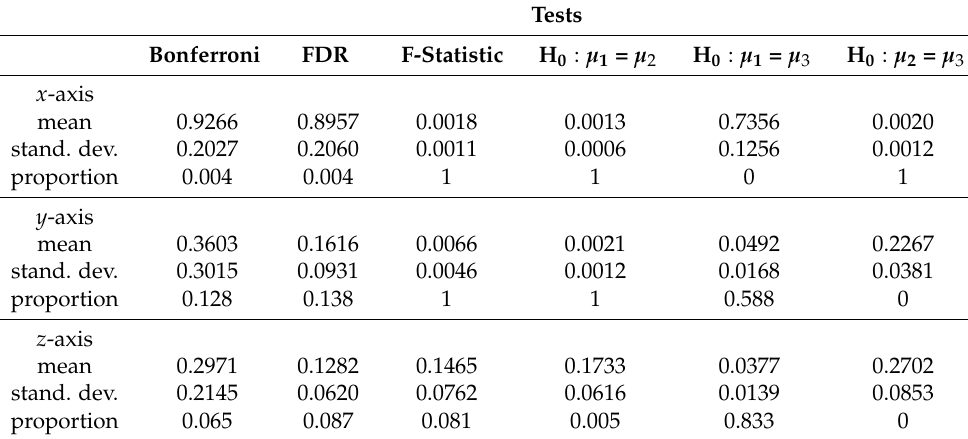
Table 1. Mean, standard deviation and proportion of values smaller or equal than 0.05 of 1000 p -values resulting of applying separately for each coordinate axis, x , y and z , the hypothesis tests: functional ANOVA tests based on random projections using the Bonferroni correction (first column) and the FDR (second column), functional ANOVA test based on the F-statistic (third column) and functional test of means based on the L 2 norm for contrasting the acceleration curves corresponding to patients in the early-stage of the disease against the middle (fourth column), the early against the late (fifth column) and the middle against the late (sixth column).